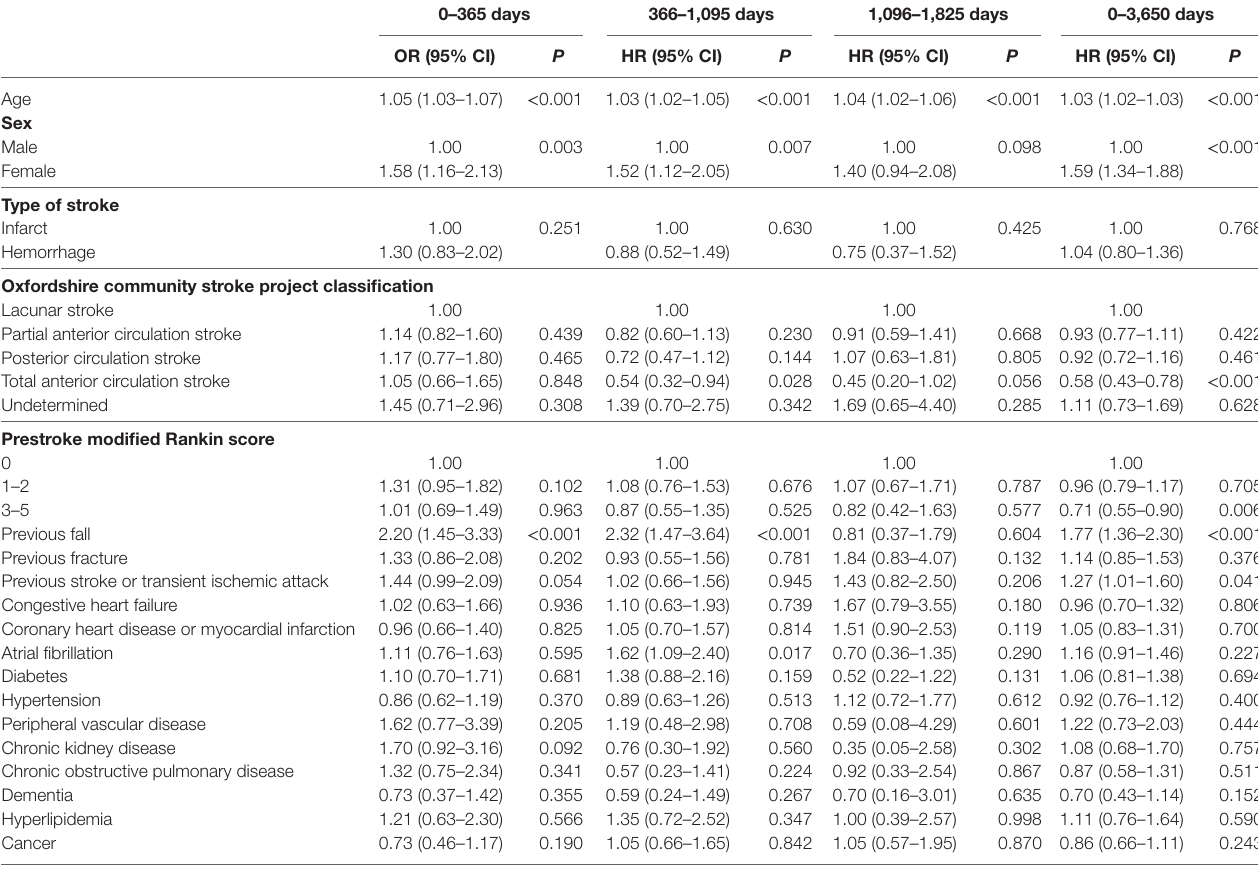
TaBle 5 | Multivariable analysis of risk factors for poststroke fractures over time after